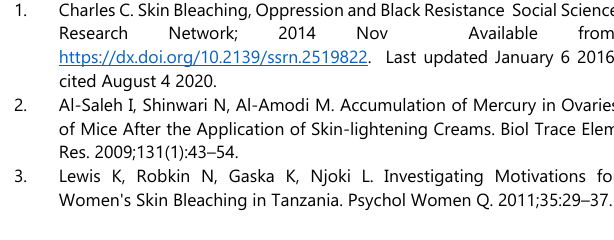
Legend: Table 2 shows the clinical relevance of urinary mercury